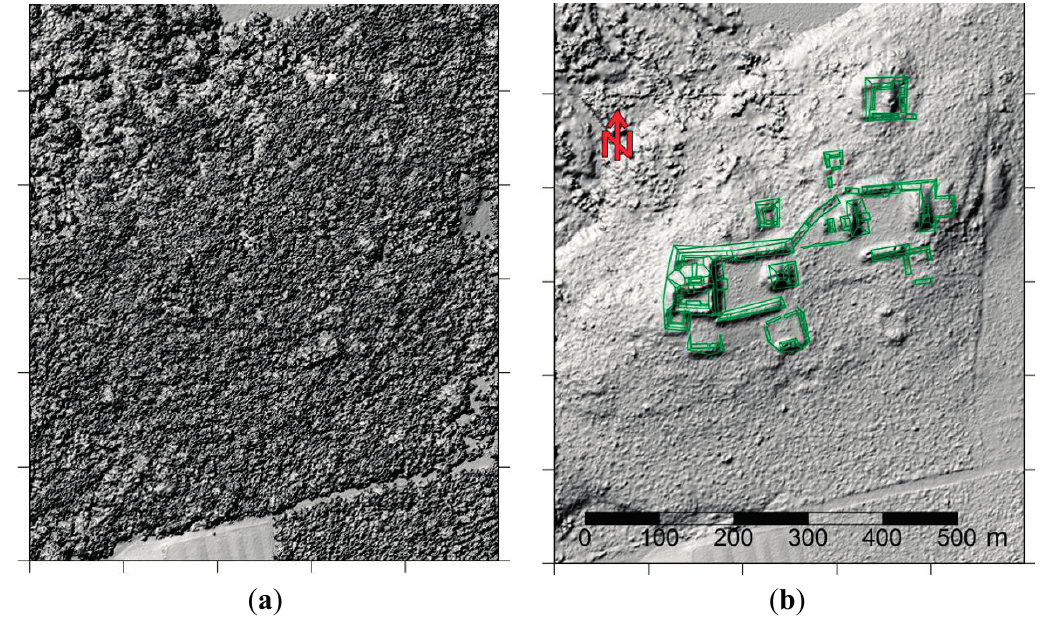
Figure 25. Overlay of field survey data over an ALS data derived DEM for the LWD site close to San Ignacio in central Belize. ( a ) Shaded relief image of DSM; ( b ) field data overlaid on shaded relief image of